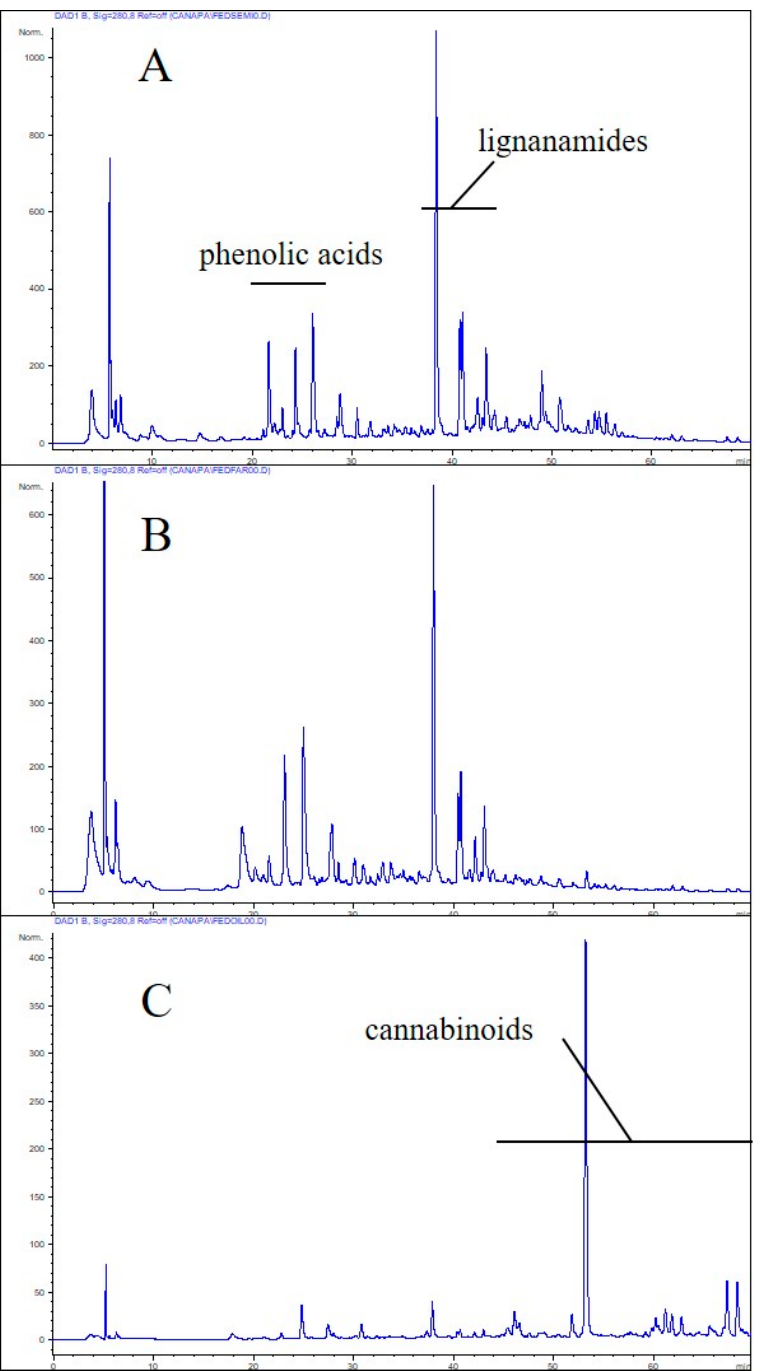
Figure 1. Reversed phase-high performance liquid chromatography (RP-HPLC) chromatograms of hydroalcoholic extracts from seeds ( A ), flour ( B ) and oil ( C ) of hemp Fedora cv. The seed and flour extracts share a very similar chromatographic pattern, dominated by lignanamides [27]. As expected, the oil extracts exhibited a different chromatogram, which most likely included simple phenolics and cannabinoid derivatives [28].